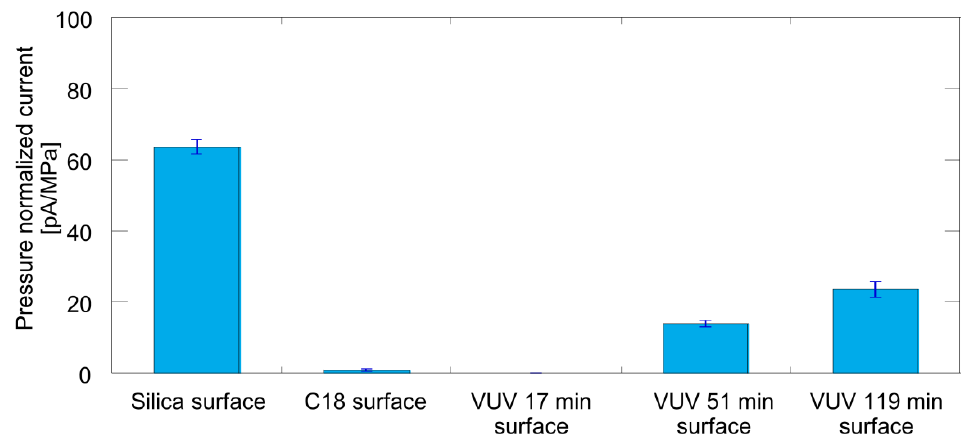
Figure 6. Comparison of streaming current corresponding to different nanochannel surfaces.